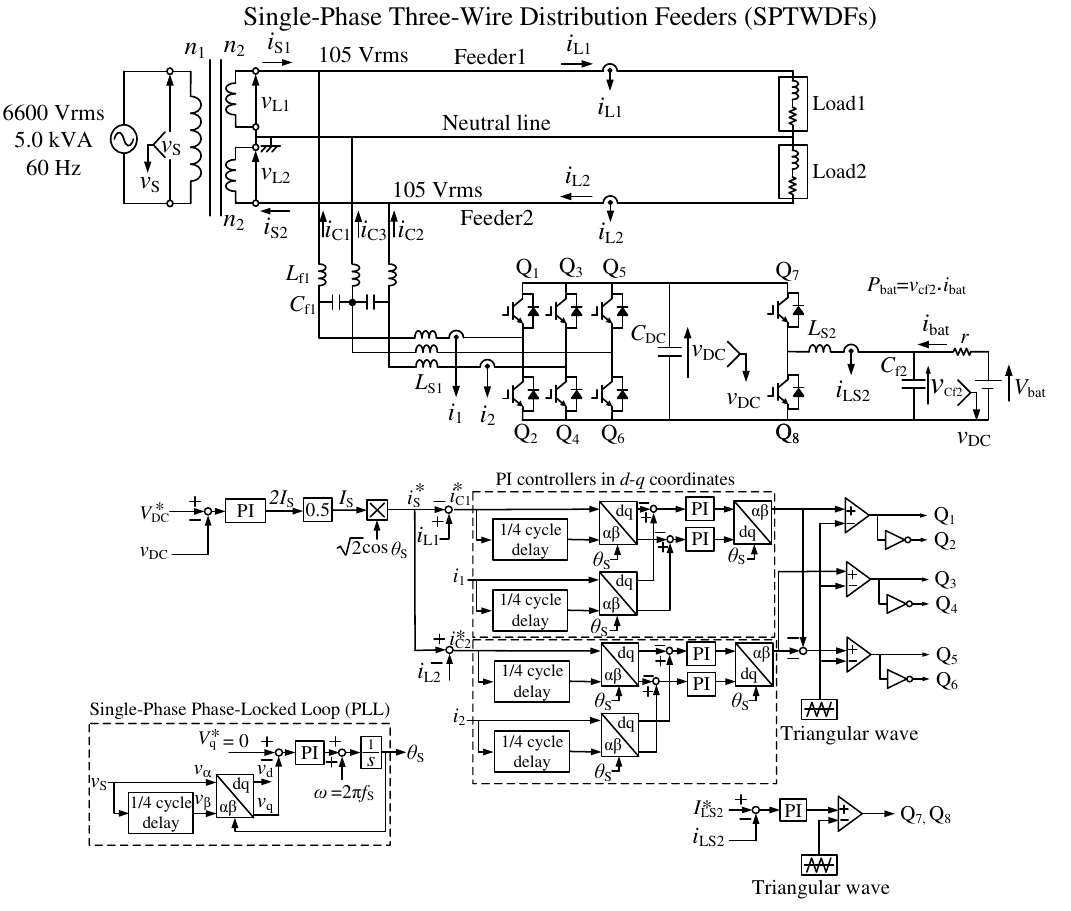
Figure 2. Power circuit diagram of the previously proposed smart charger for electric vehicles (EVs) with a power quality compensator